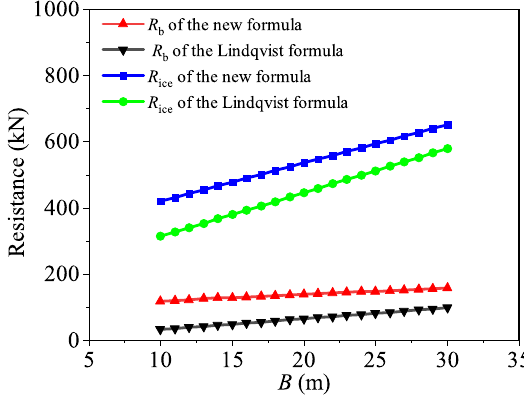
Figure 10. Variation of resistances with the ship